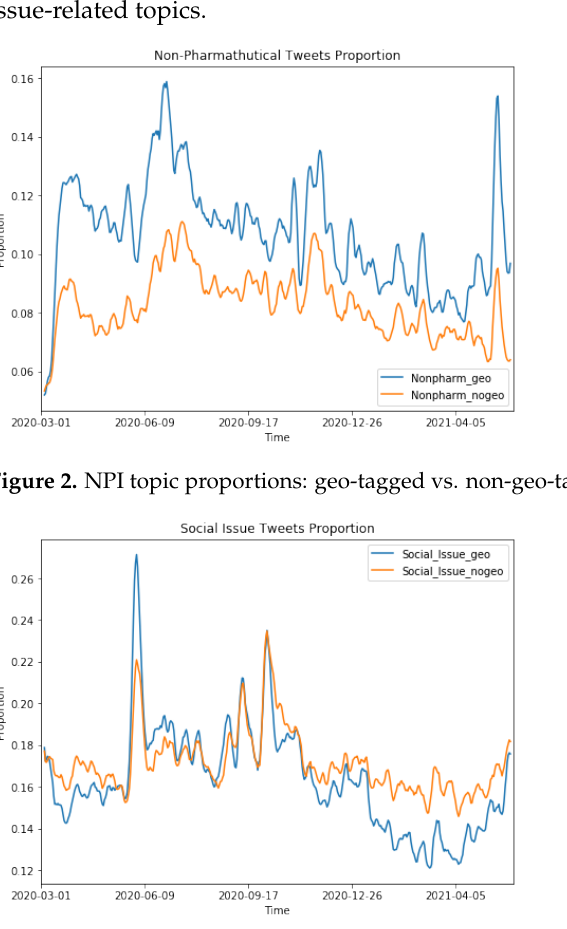
Figure 3. Social issue topic proportions: geo-tagged vs.